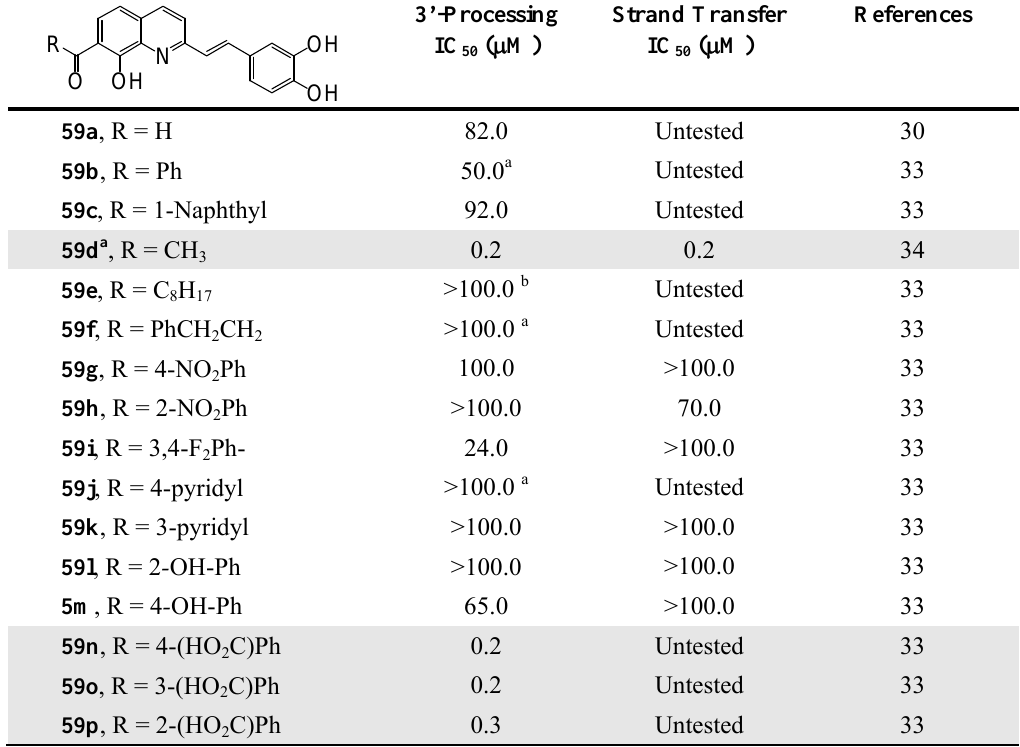
Table 4. In vitro integrase inhibition activities of the 7-aroyl-styrylquinolines derivatives. OH OHR N OH O